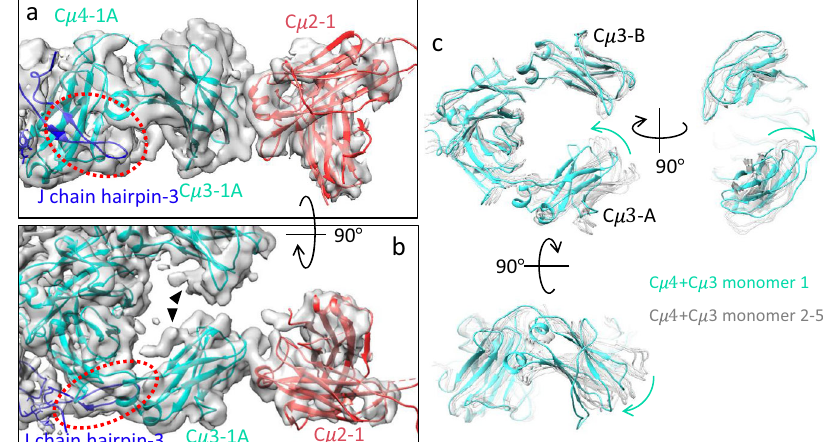
Fig.2|StabilisationofC μ 2domaininsubunit1.a , b Zoomed-inviewatthreshold 0.6ofC μ 2-1 (red, pdb id4JVU),C μ 3-1A- C μ 4-1A(cyan, pdbid6KXS)and hairpin-3 of J-chain (dark blue) showing the relationships between the domains. The red dotted ellipse highlighting the interacting sections between J-chain and C μ 3-1A. The black arrowheads in ( b ) point at the densities corresponding to N-linked